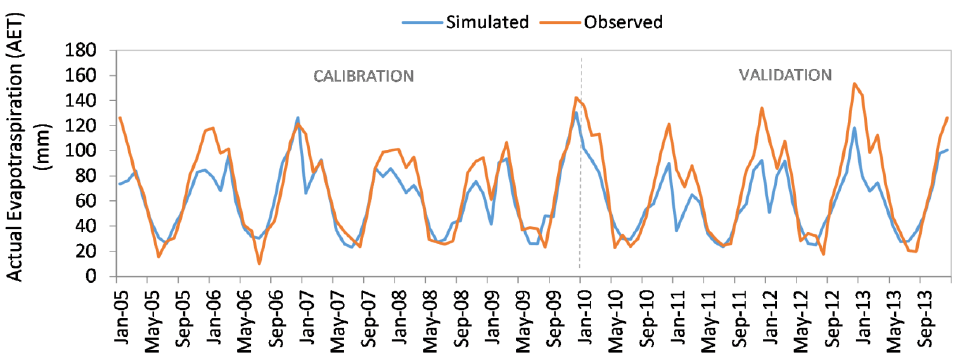
Figure 2. SWAT model calibration and validation for the period 2005–2013. Evapotranspiration data from SSEBOP compared to the obtained data from our simulated model.